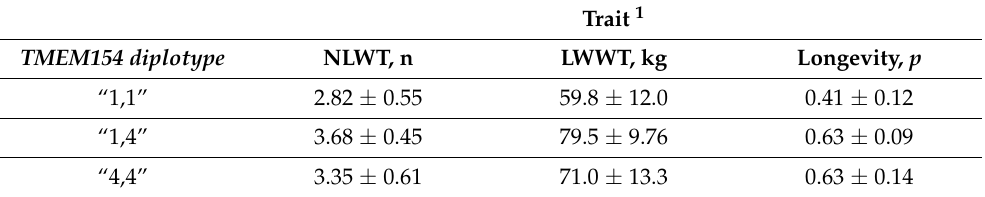
Table 5. Least-square means ( ± SE) for the main effect of TMEM154 diplotype on reproductive performance and longevity through four production years in Experimental flock